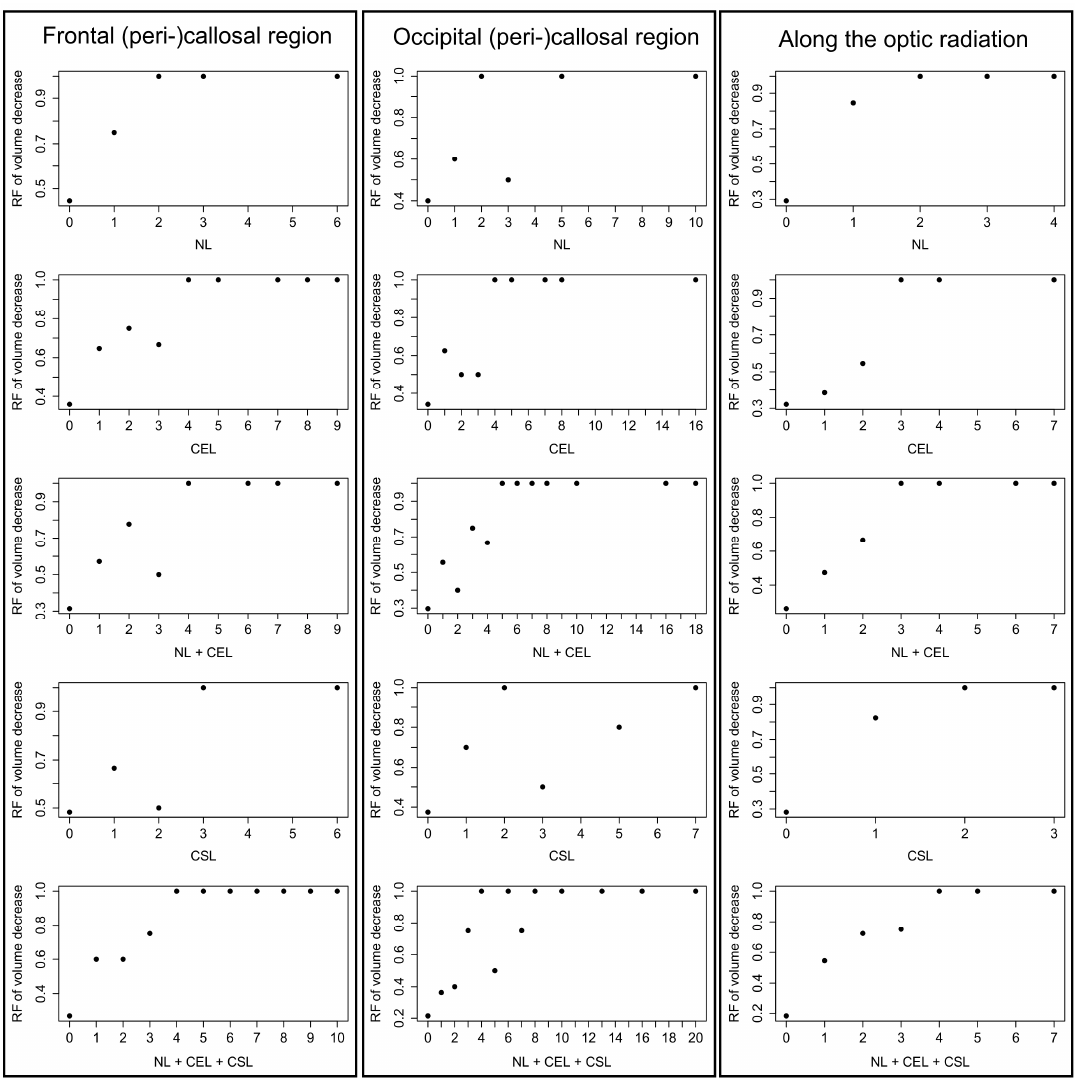
Figure 4. Relative Frequencies (RF) of volume decrease at given lesion counts in individual patients. The left column lists the number of lesions ( x -axis) in the frontal (peri-)callosal region and the relative frequency of callosal volume reduction ( y -axis). The center column considers lesions in the occipital (peri-)callosal region and the relative frequency of callosal volume reduction. The right colum considers lesions in the region along the optic radiation and volume decrease of the LGN.